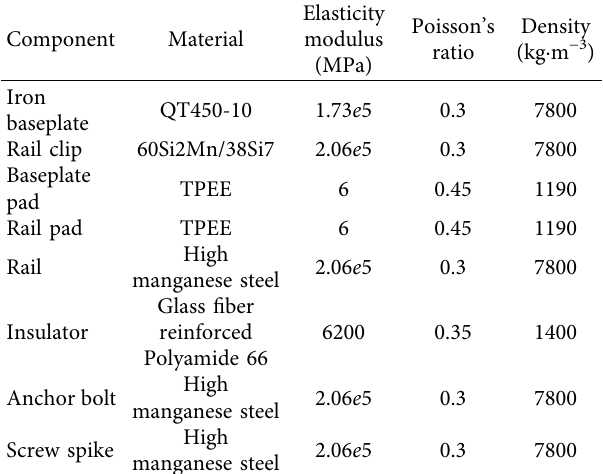
Table 3: Material parameters of each